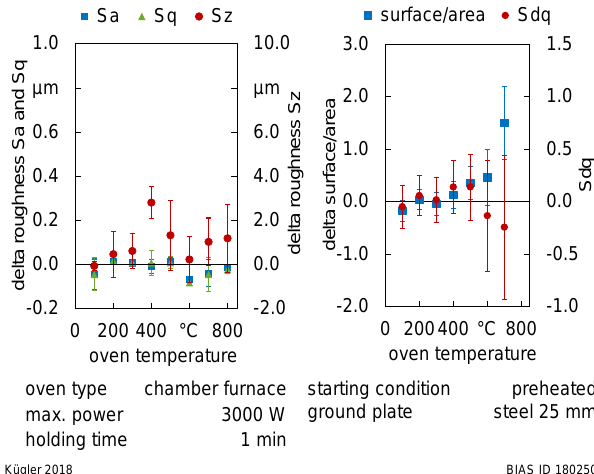
Figure 12. The influence of oven heating on standard roughness values ( left ), hybrid roughness value Sdq, and the topography factor of surface/area ( right ).